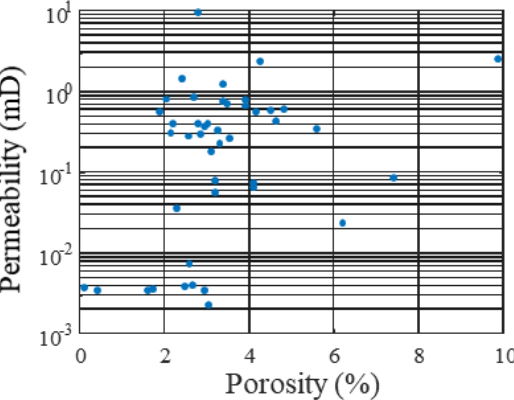
Figure 4. Relationship between permeability and porosity. The blue circles are experimental data.